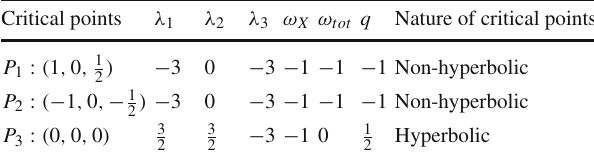
Table 1 The cosmological parameters, eigenvalues ( λ 1 , λ 2 , λ 3 ) and the nature of critical points for this non-interacting model Critical points λ